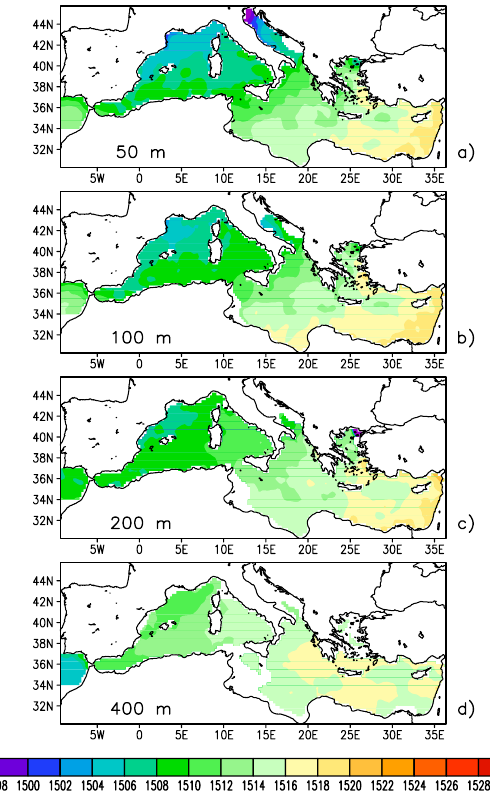
Fig. 6. Sound speed monthly mean (m/s) in August at 50m (a) , 100m (b) , 200m (c) and 400m (d)